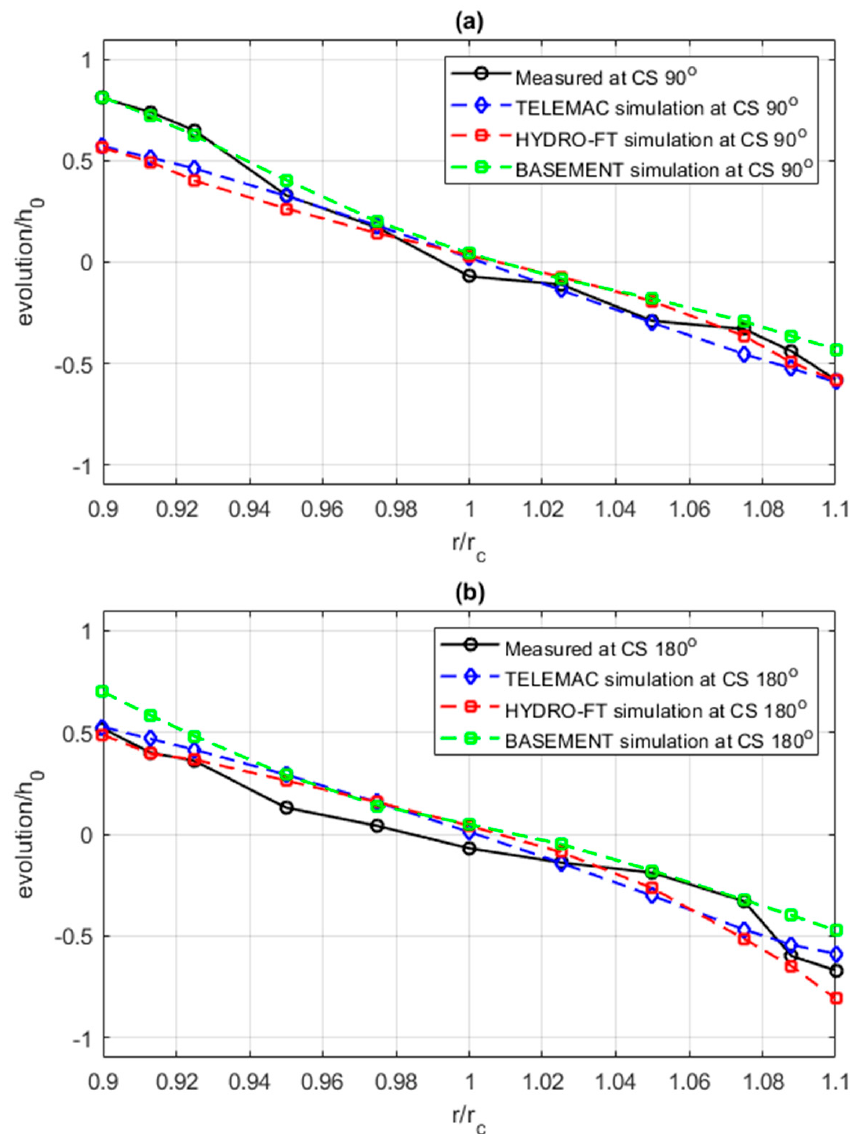
Figure 8. Comparison between measured and simulated bed evolutions normalized by the initial water depth after 5 h: ( a ) at the 90° cross-section; and ( b ) at the 180° cross-section. Table 4. Transverse variation of non-dimensional bed deformation ∆ z / h 0 at sections of maximum deposition and scour (90° and 180° sections). r/r c at 90° Section 0.900